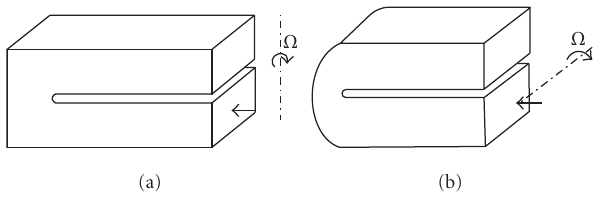
Figure 1: Flow geometries and modes of rotation: (a) square-ended U-bend, and (b) round-ended